Question: What style of plot is this figure drawn as?
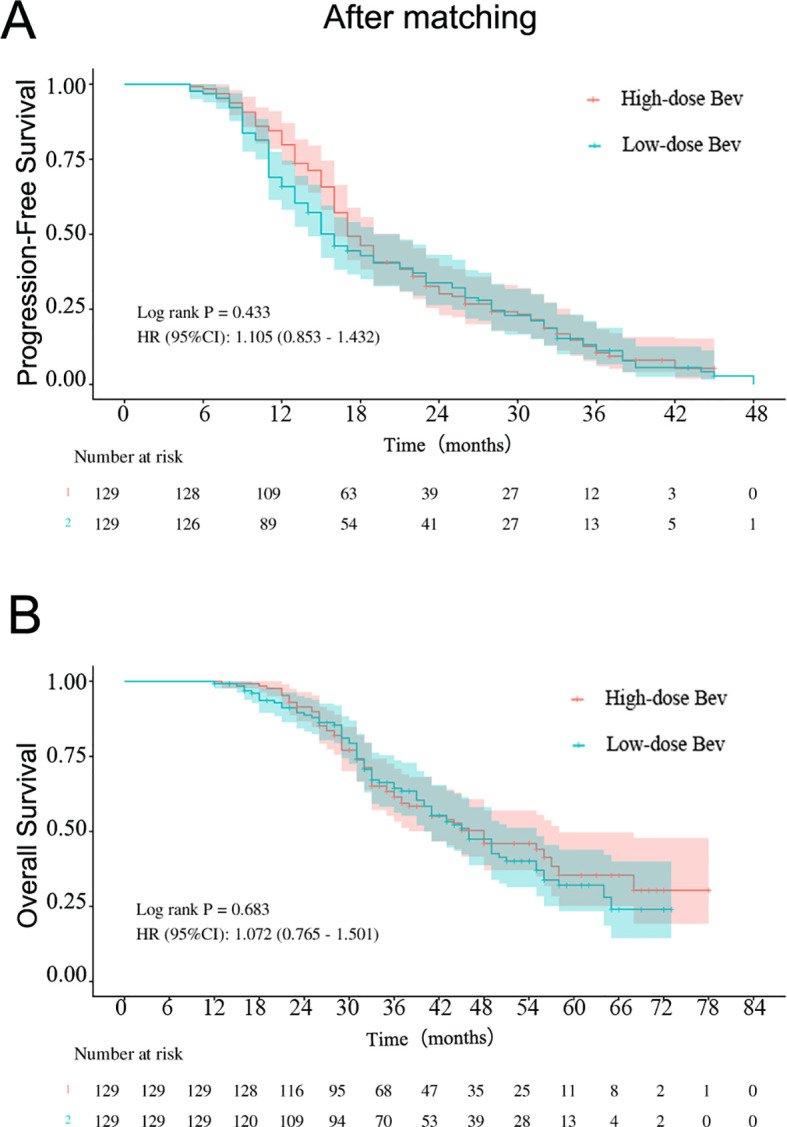
Answer: survival